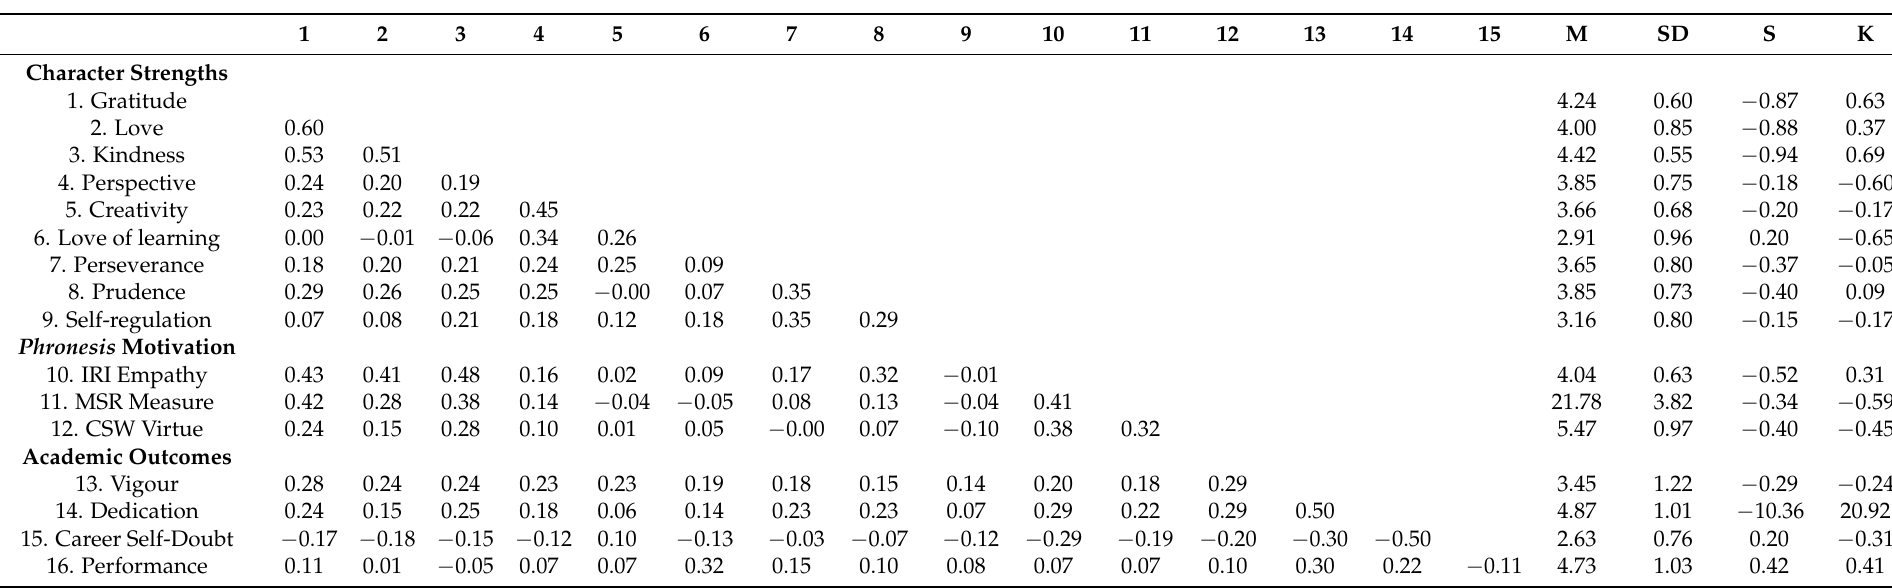
Table 1. Bivariate correlations and descriptive statistics of character strengths, phronesis motivation and academic